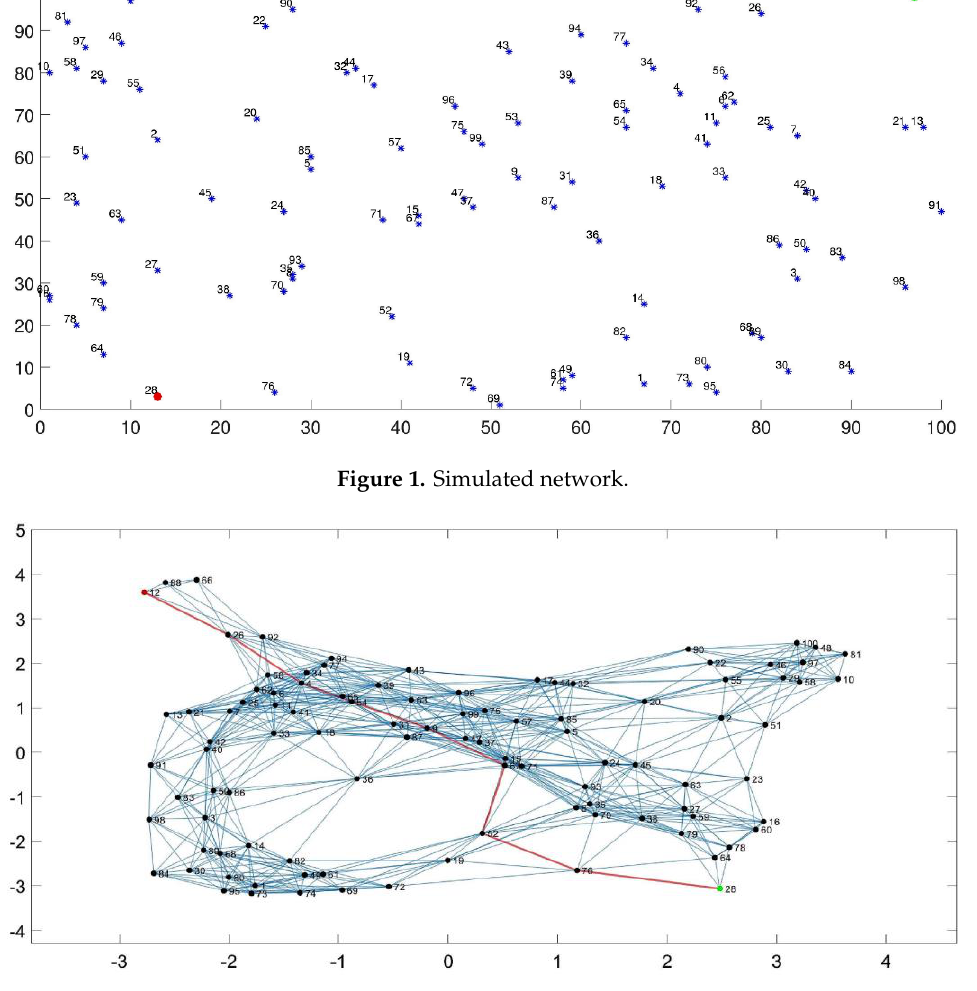
Figure 2. The network as a graph.